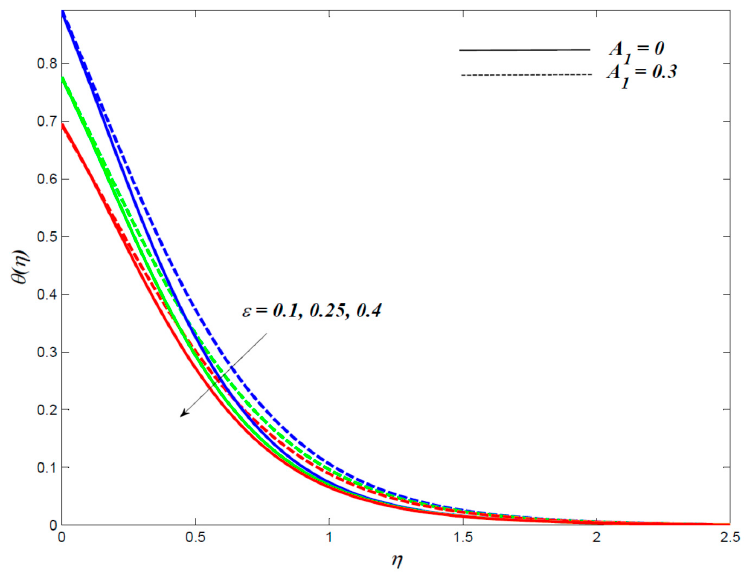
Figure 9. Temperature profiles owing to varying values of Ec.